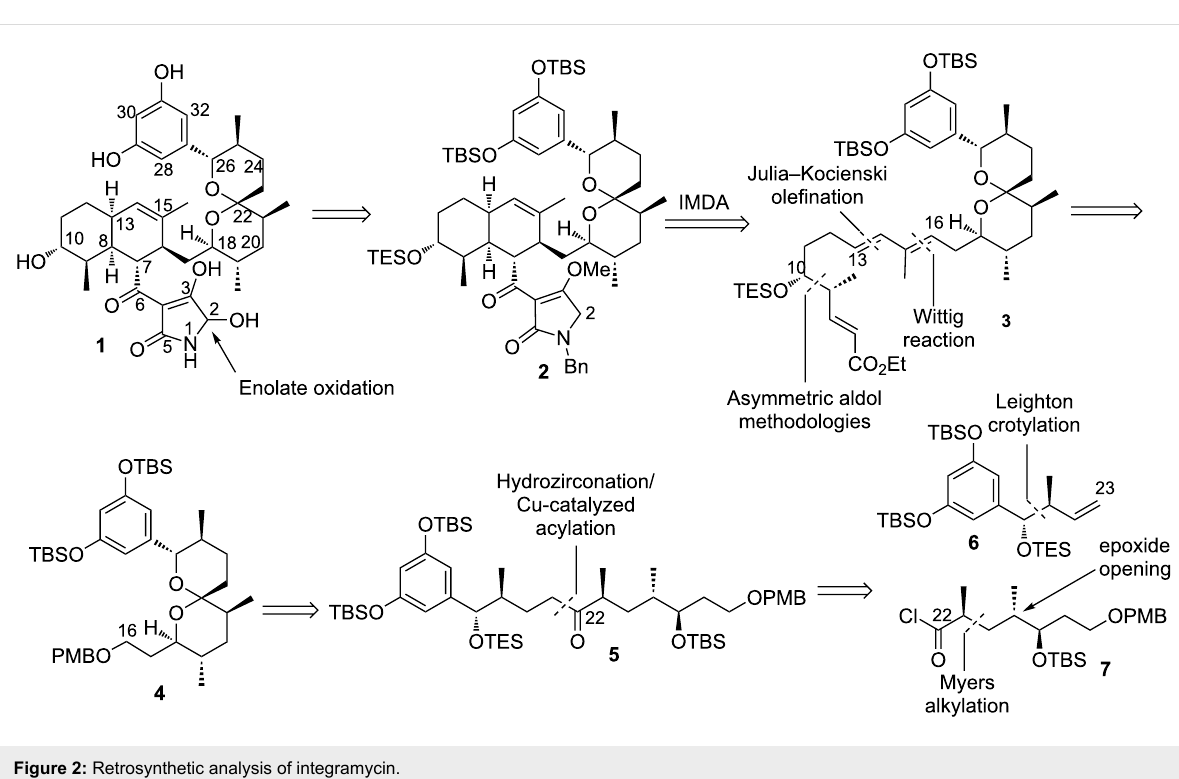
Figure 2: Retrosynthetic analysis of